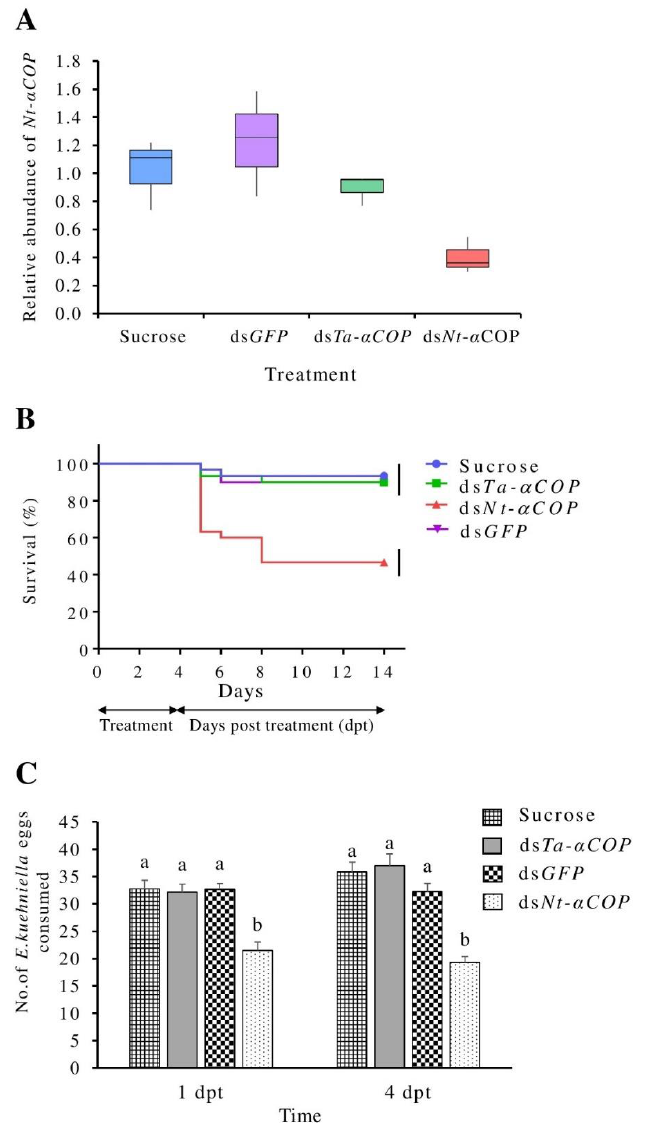
Figure 2. Effect of homologous and non-homologous dsRNA on survival and predation rate of N. tenuis . ( A ) Relative quantification of the endogenous Nt-αCOP gene expression by RT-qPCR. The treatments tested were sucrose, sucrose+ds GFP , sucrose+ds Ta - αCOP , and sucrose+ds Nt-αCOP . Results were obtained from three biological replicates. For normalization, ATPB was used as the internal control. Relative expression values were obtained using the 2 −∆∆CT method. For statistical analysis, the Student’s t-test was employed. The expression levels of Nt-αCOP in ds Nt-αCOP treatment significantly differ ( p < 0.05) in comparison to the other three treatments. ( B ) Mean survival curves of N. tenuis fed from 0 to 4 d on sucrose, sucrose+ds GFP , sucrose+ds Ta-αCOP , sucrose+ds Nt-αCOP and subsequently fed with E. kuehniella eggs for 10 days on a tomato leaflet. Curves terminating at the different vertical bars are significantly different according to the log-rank test ( p < 0.0001). ( C ) Number of E. kuehniella eggs consumed per N. tenuis individual at 1 and 4 dpt, after feeding for 4 d on sucrose, sucrose+ds GFP , sucrose+ds Ta-αCOP , sucrose+ds Nt-αCOP . Columns followed by different letter differ significantly ( p < 0.05).